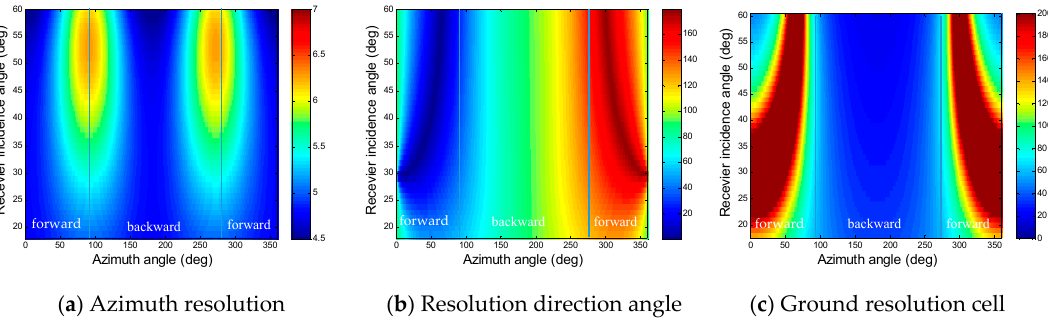
Figure 7. The resolution analysis with respect to θ R and ϕ R . ( a ) Azimuth resolution; ( b ) Resolution direction angle; ( c ) Ground resolution cell when θ T = 29.55 ◦